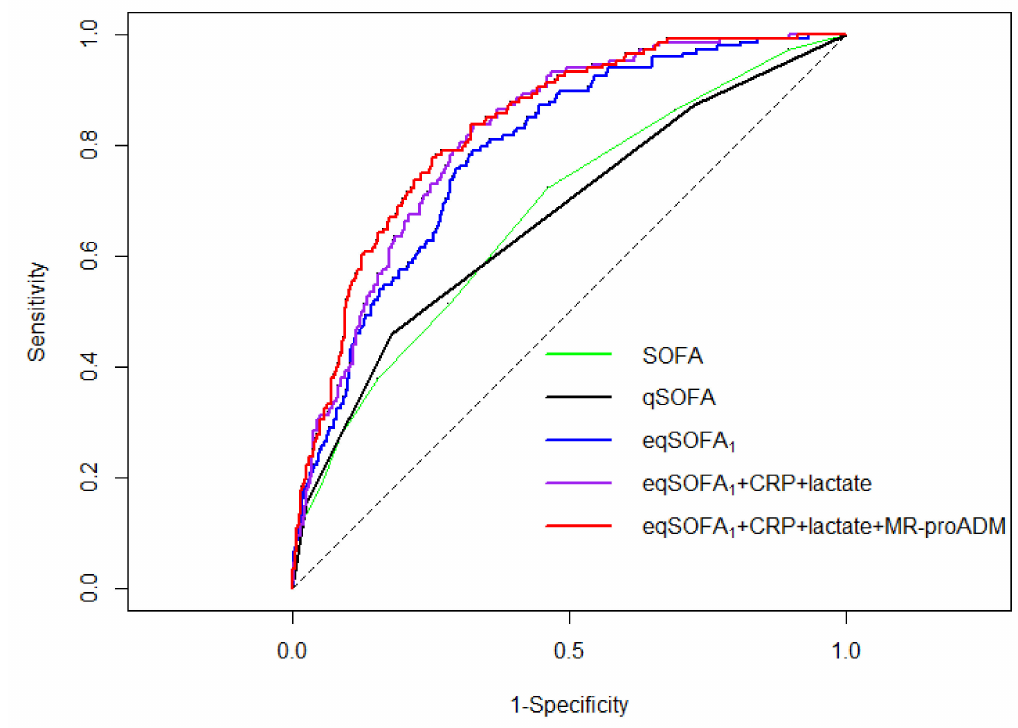
Figure 1. Group 1: Receiver operating characteristic curves of the sequential organ failure assessment (SOFA), quick sepsis-related organ failure assessment (qSOFA), “extended” qSOFA derived in Group 1 (eqSOFA 1 ), eqSOFA 1 integrated with serum concentrations of C-reactive protein and lactate (eqSOFA 1 + CRP + lactate) and eqSOFA 1 combined with serum concentrations of C-reactive protein, lactate and mid–regional proadrenomedullin (eqSOFA 1 + CRP + lactate + MR-proADM) to predict 30-day